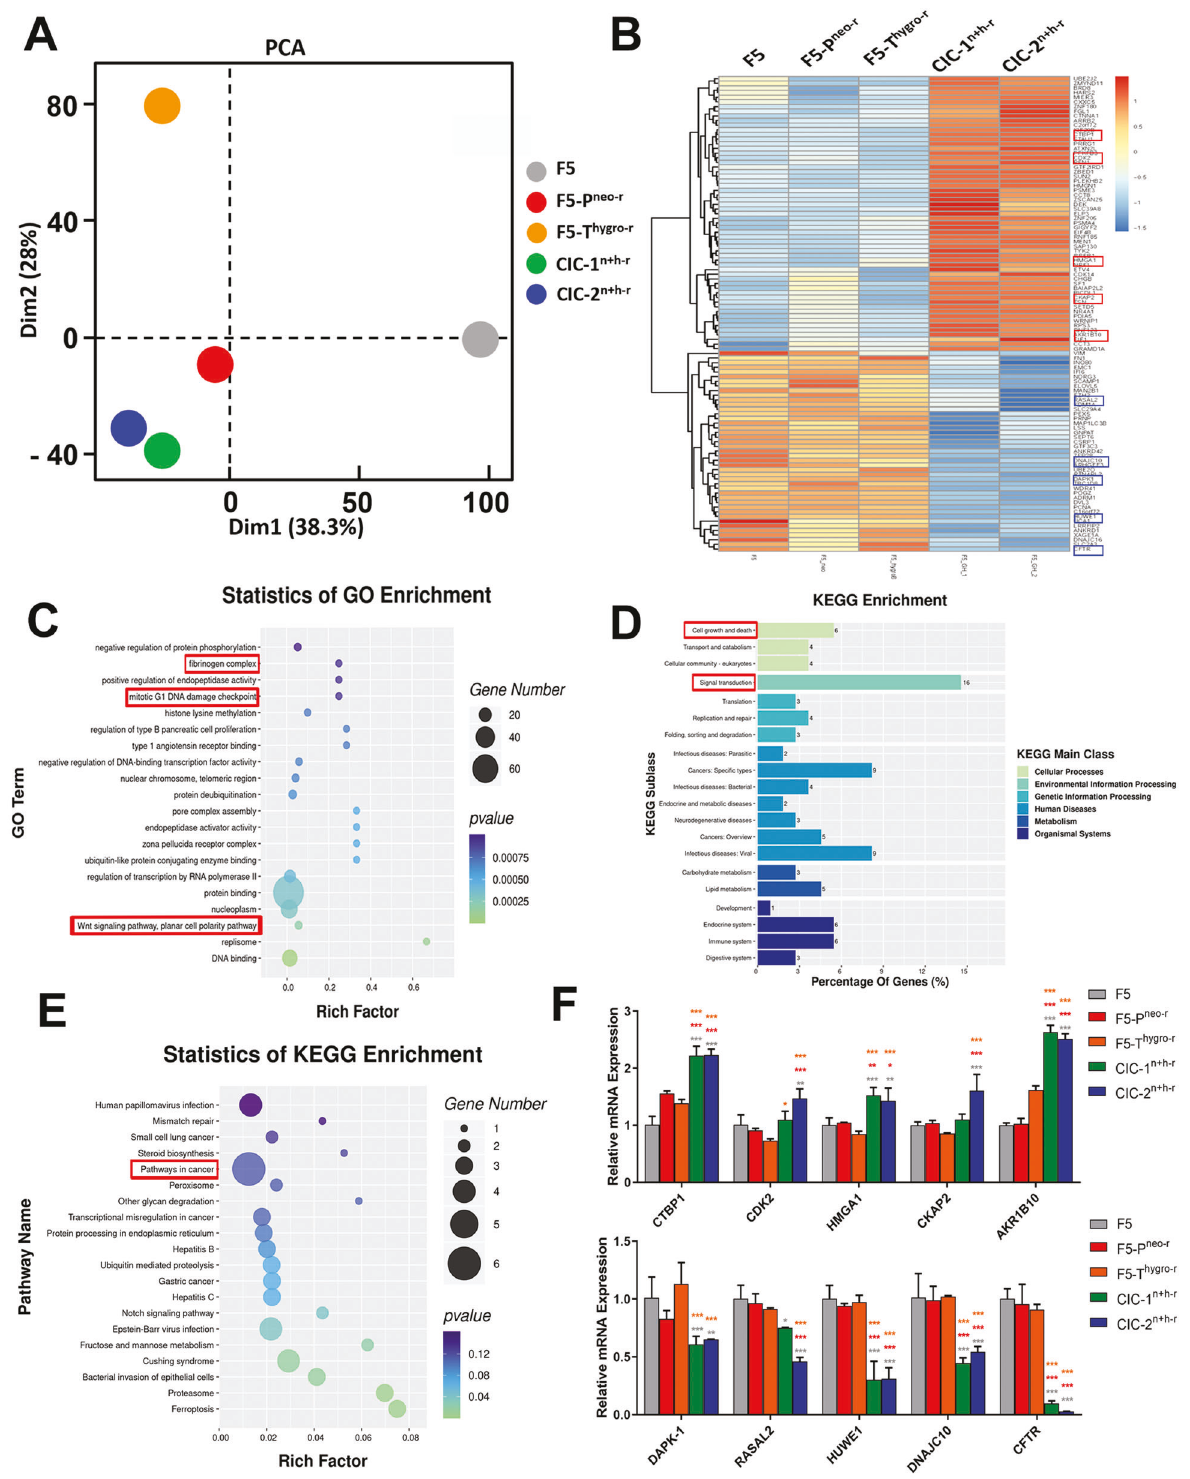
Fig. 6 The transcriptional changes of the dual-antibiotic-resistant derivative CIC n + h-r compared to parental cells. A The principle component analysis of F5, F5-P neo-r , F5-T hygro-r , CIC-1 n + h-r and CIC-2 n + h-r cells. B The colors of the heatmap re fl ect log 2 (Differentially expressed genes) in F5, F5-P neo-r , F5-T hygro-r , CIC-1 n + h-r and CIC-2 n + h-r cells. C GO term analysis of differently expression genes (DEGs). D KEGG pathway analysis of signal transduction pathways involved in CIC-1 n + h-r and CIC-2 n + h-r cells compared to F5, F5-P neo-r , F5-T hygro-r cells. E Statistics of KEGG enrichment of CIC-1 n + h-r and CIC-2 n + h-r cells compared to F5, F5-P neo-r , F5-T hygro-r cells. F Relative mRNA expression of differently expression genes in CIC-1 n + h-r and CIC-2 n + h-r cells compared to F5, F5-P neo-r , F5-T hygro-r cells.